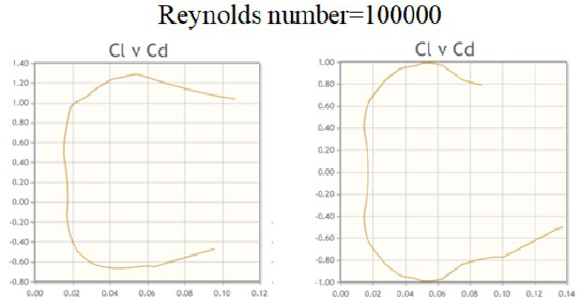
Figure 14. Geometries of NACA0012 (a) α=0°, (b) α = -5°, and (c) NACA2415 at α = 5°